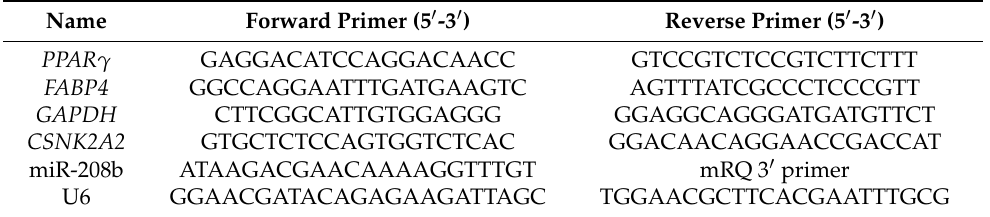
Table 2. The primer sequences were used for the qRT-PCR